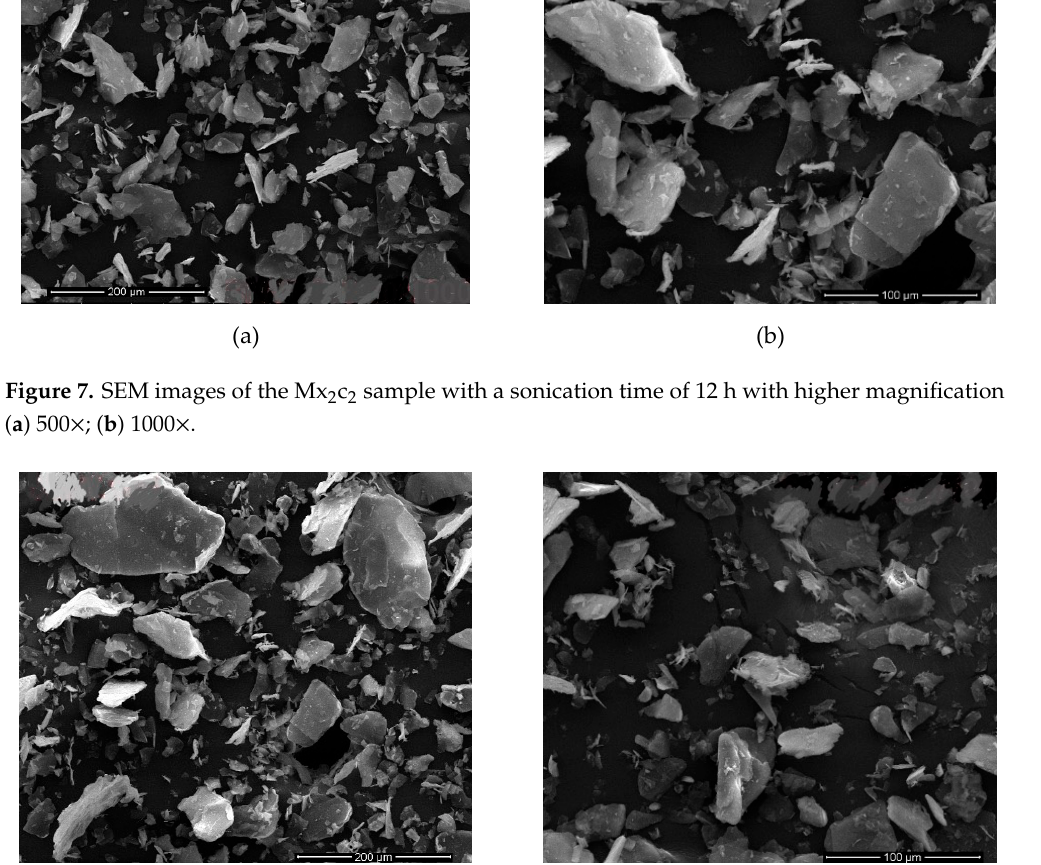
Figure 8. SEM images of the M x2c2 sample with a sonication time of 5 h with higher magnification ( a ) 500×; ( b ) 1000×.